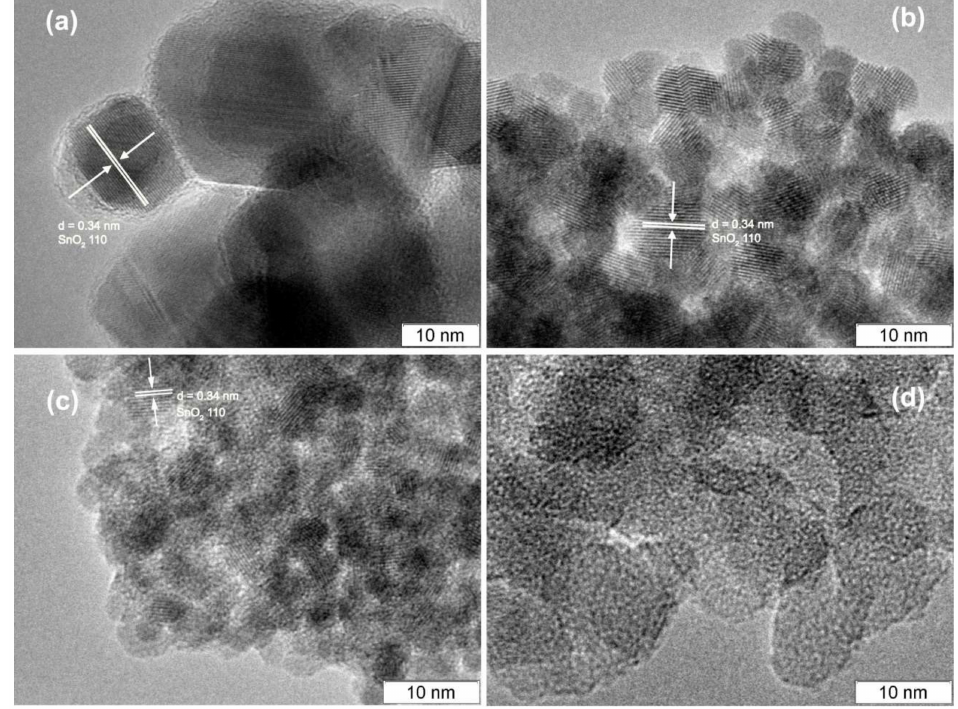
Figure 6. HREM images of: ( a ) SnO 2 ; ( b ) SnSi13; ( c ) SnSi49; ( d ) SiO 2